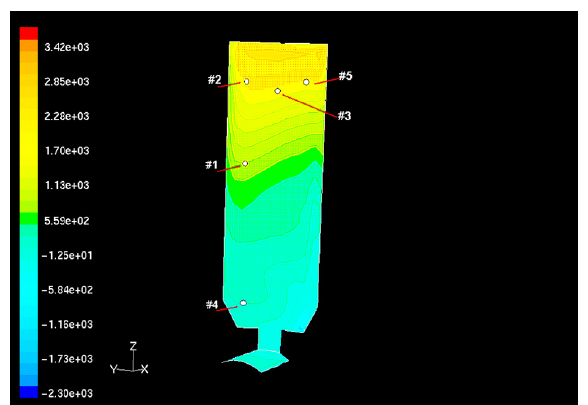
Figure 21: Dynamic pressure on the pressure side with radiator (unit in Pascal).